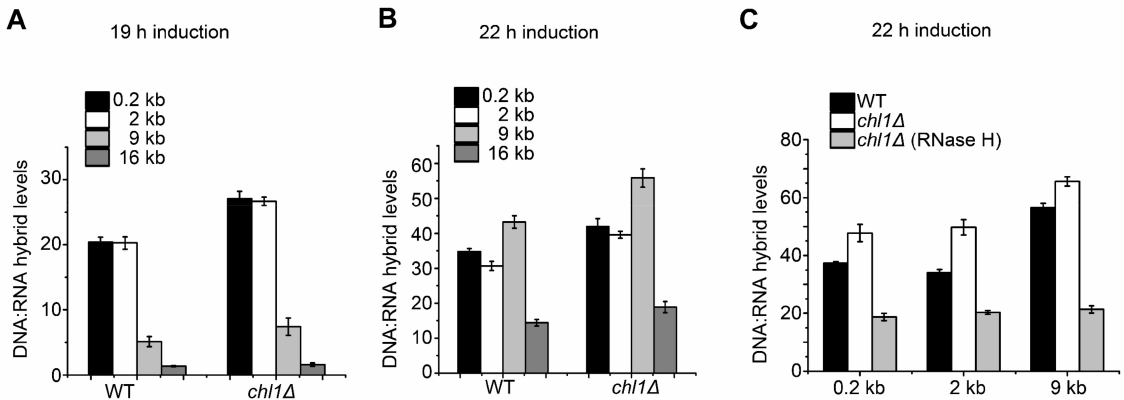
Figure 3. Chl1 reduces DNA:RNA hybrid levels around DSB sites: ( A , B ) After 19 and 22 h of HO induction, ChIP–qPCR was performed using antibody S9.6, which specifically recognizes DNA:RNA duplexes in the indicated strains; ( C ) ChIP–qPCR results for the tested strains after 22 h of HO induction, with or without RNase H digestion. The results are represented as the mean ± SEM of three independent